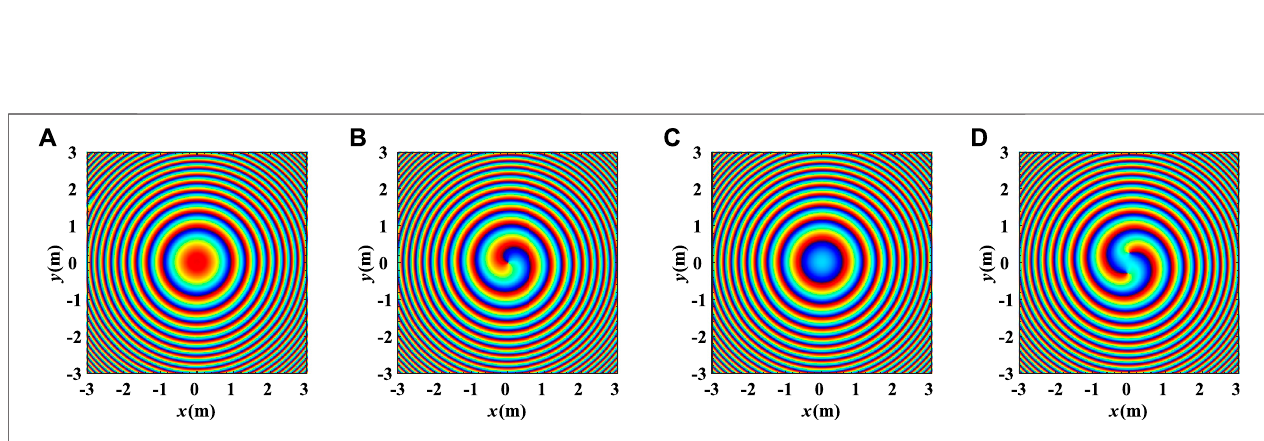
, θ , ϕ ) (cid:1) ( 2 . 5 m , 0 ° , 0 ° ) ;and (D) observation t t t